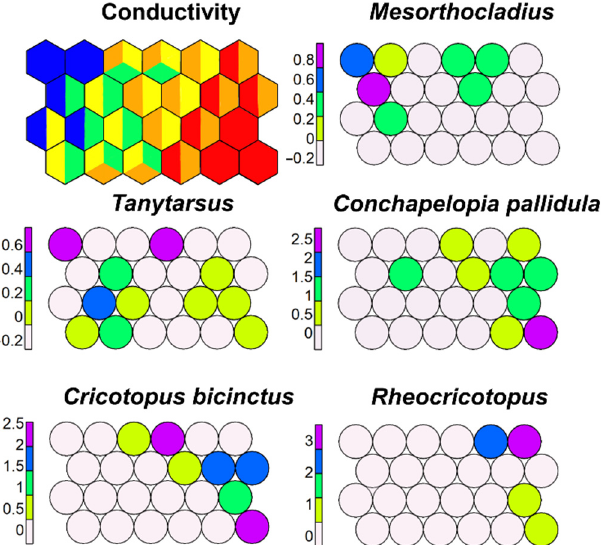
Figure 16. Supervised map of sites and five morphotaxa clustered using conductivity (in µS cm − 1 ) as external variable. Blue, <100 µS cm − 1 ; green, 100–200 µS cm − 1 ; yellow, 200–300 µS cm − 1 ; orange, 300–400 µS cm − 1 ; red, >400 µS cm − 1 .